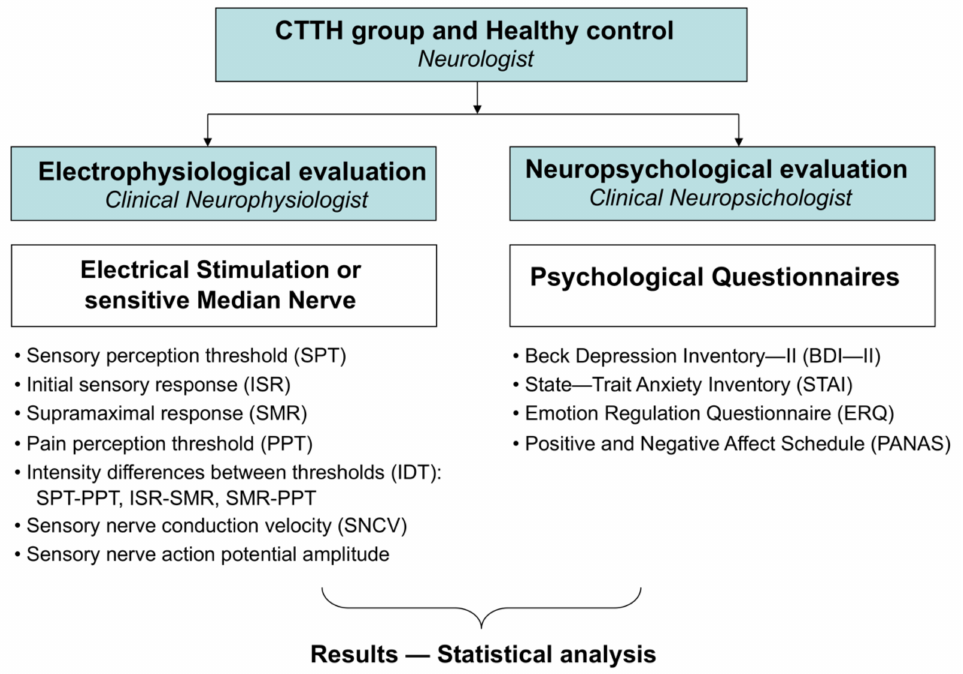
Figure 2. Methodological